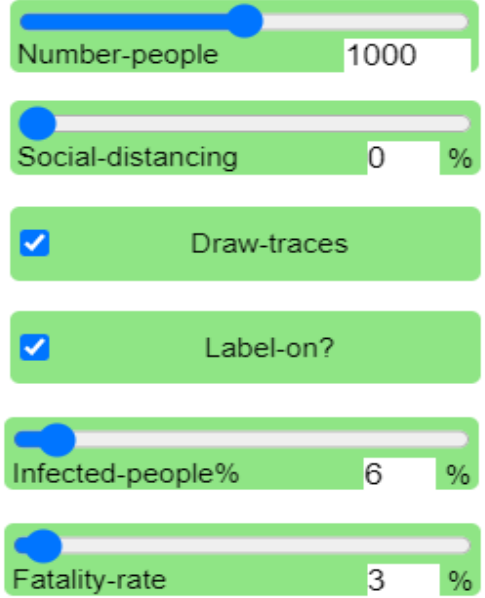
Figure 4. Sliders and switches of the NetLogo software interface.